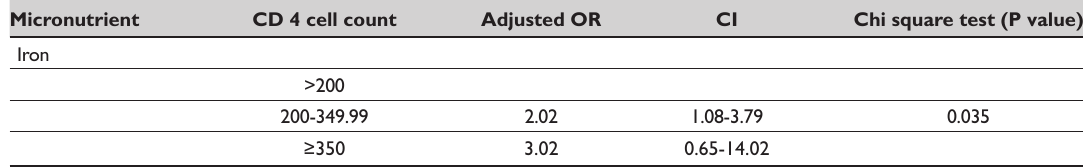
Table 5: Multivariate analysis for association of micronutrient intake by CD 4 cell count among HIV+ patients initiating HAART after adjusting for duration on HAART and use of multivitamins Micronutrient